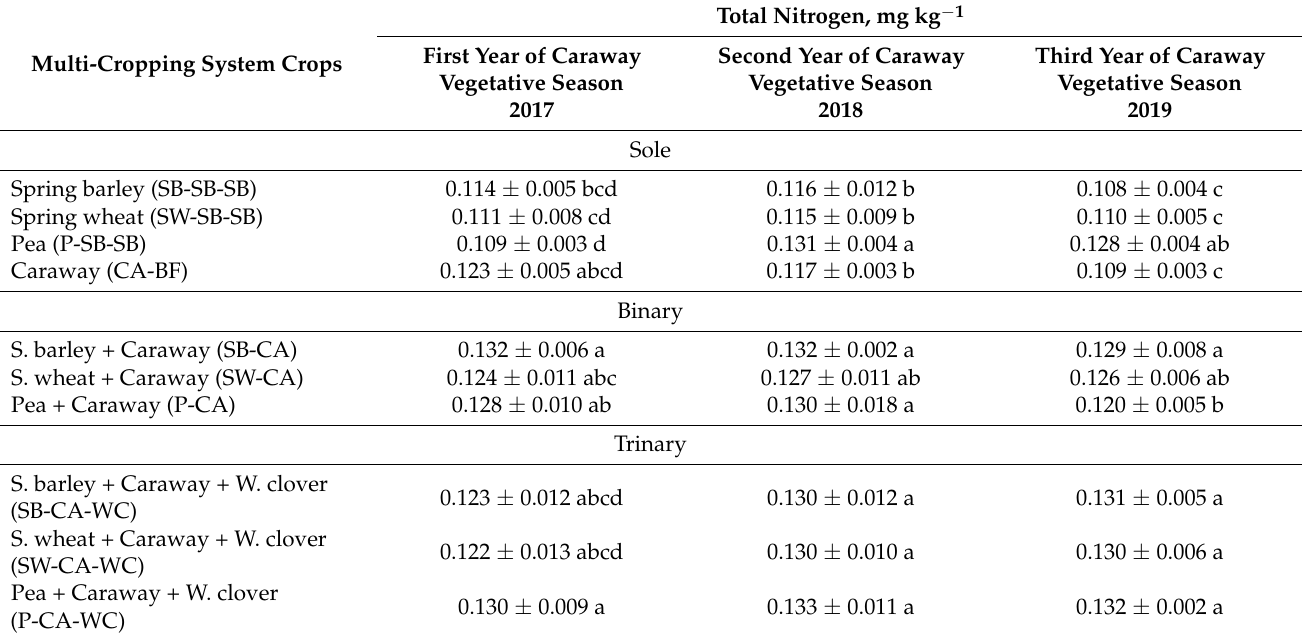
Table 1. Total nitrogen content in the soil of sole, binary, and trinary crops in